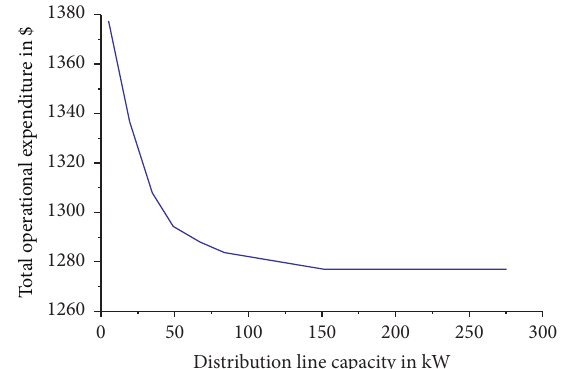
Figure 13: Total operating cost for various capacities of the transmission line.